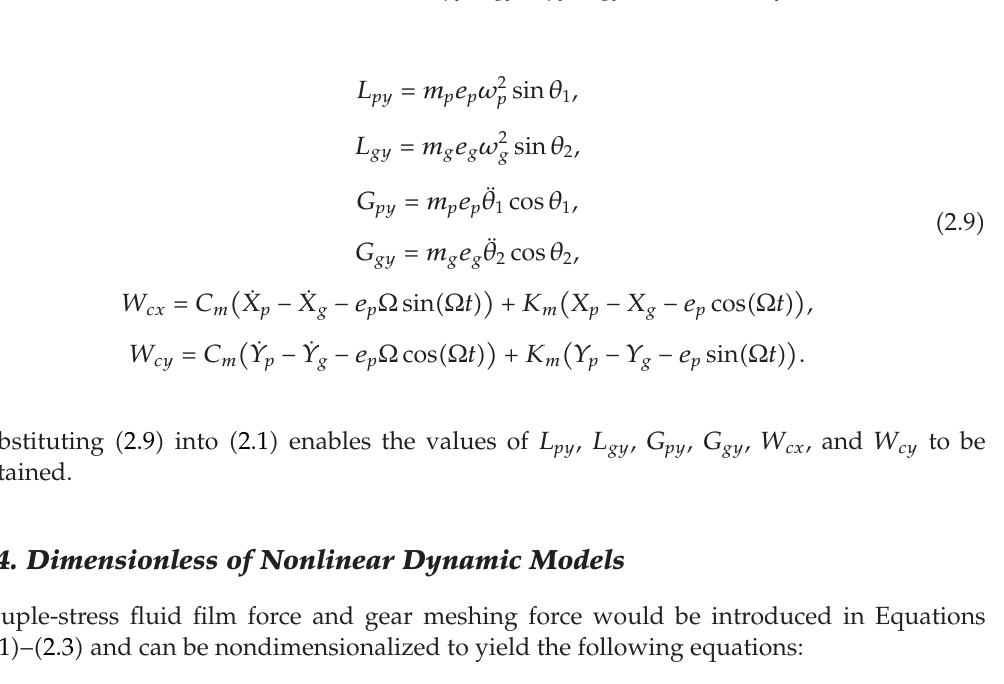
mesh force in the vertical direction. Thus, L py , L gy , G py , G gy , W cx , and W cy can be